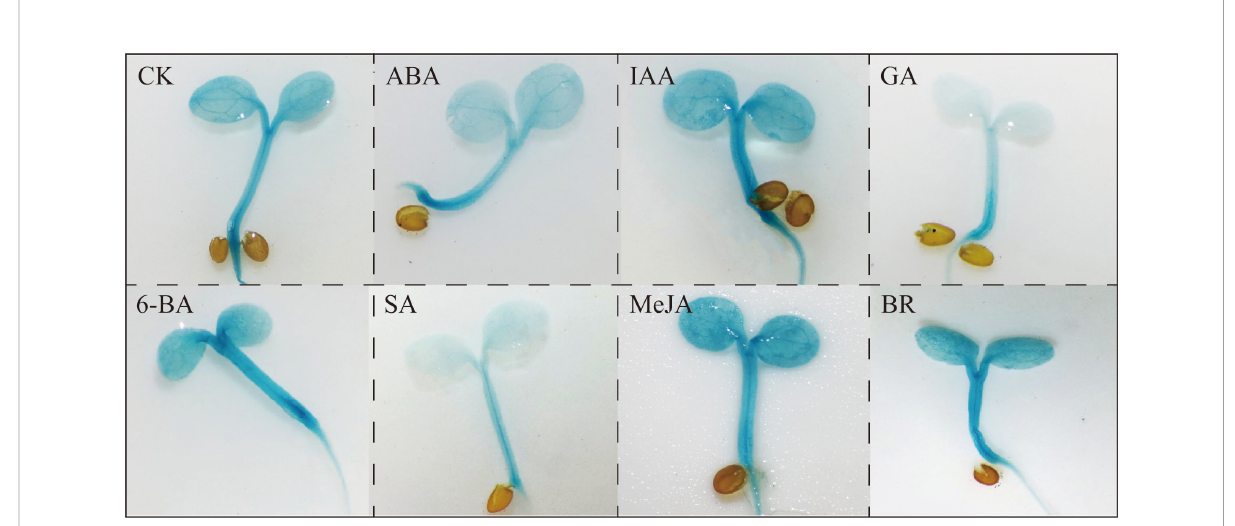
FIGURE 8 Patterns of b -glucuronidase (GUS) staining in Arabidopsis carrying p BcProGRP23 ::GUS and reporter constructs and treated with